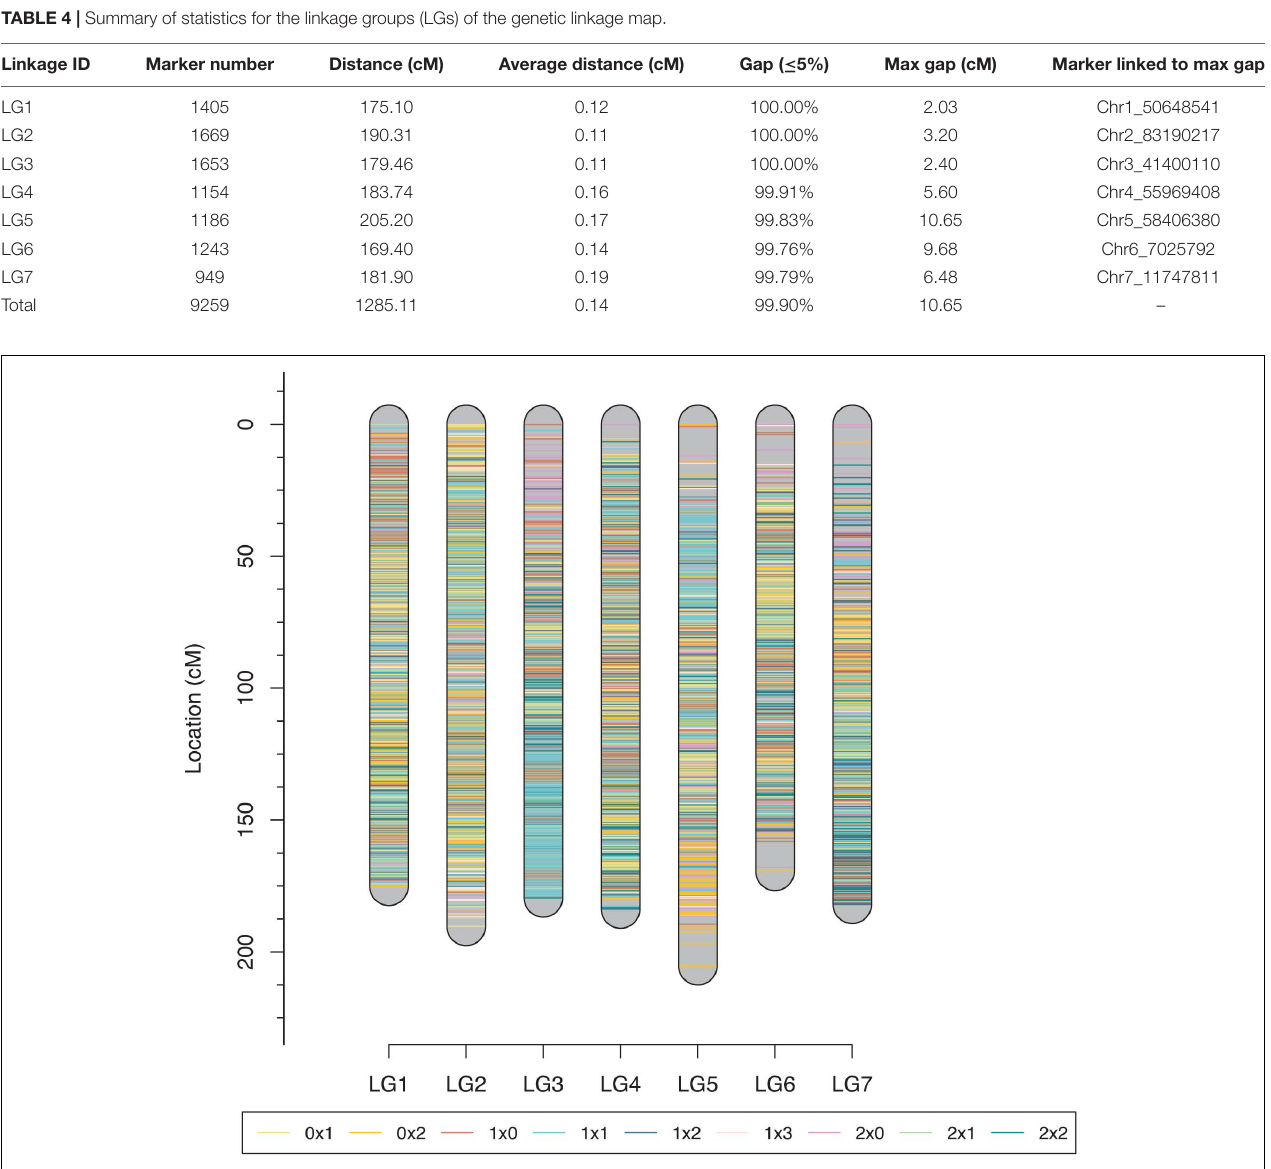
FIGURE 5 | Final integrated map for the rose YS population. Different colors represent different segregating marker types.